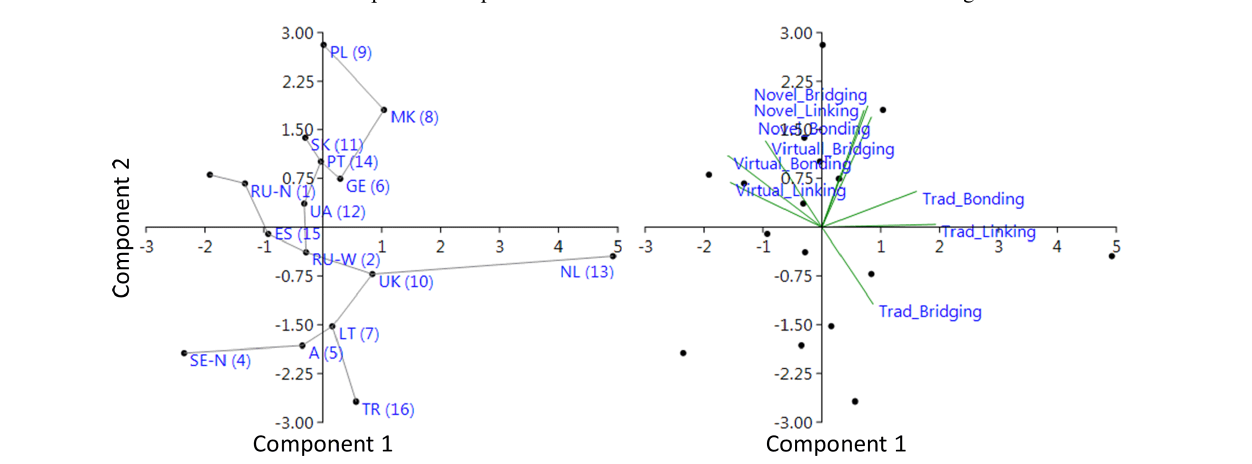
Fig. 9 . Principal component analysis ordination (left) and variable loadings (right) for 16 hotspot landscapes’ estimated strength of bonding, bridging, and linking types of social capitals. Note that the Polish and Lithuanian hotspot landscapes are identical. Data derived from Table 3 and Figure